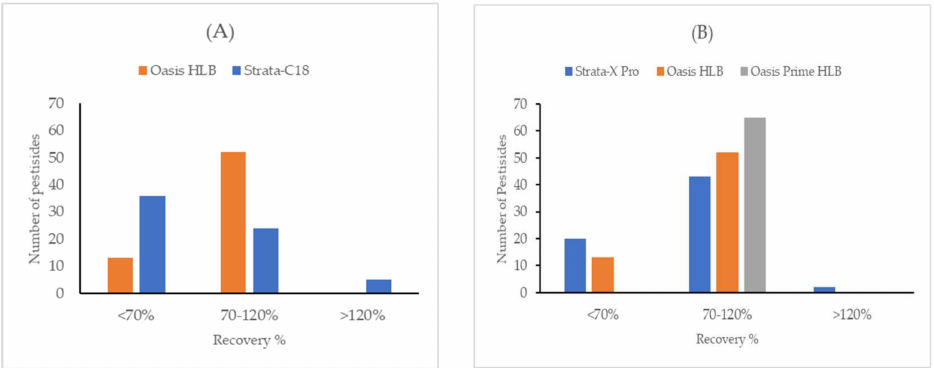
Figure 1. Comparison of recoveries for two main polymeric and silica-based sorbents ( A ) and three different polymeric SPE cartridges ( B